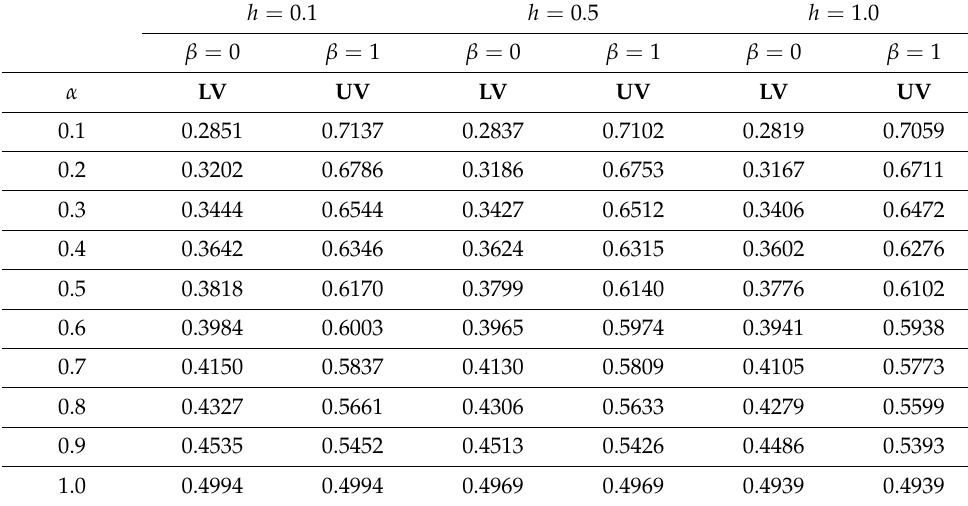
Table 7. Fuzzy solution of η at t = 0.1 s .